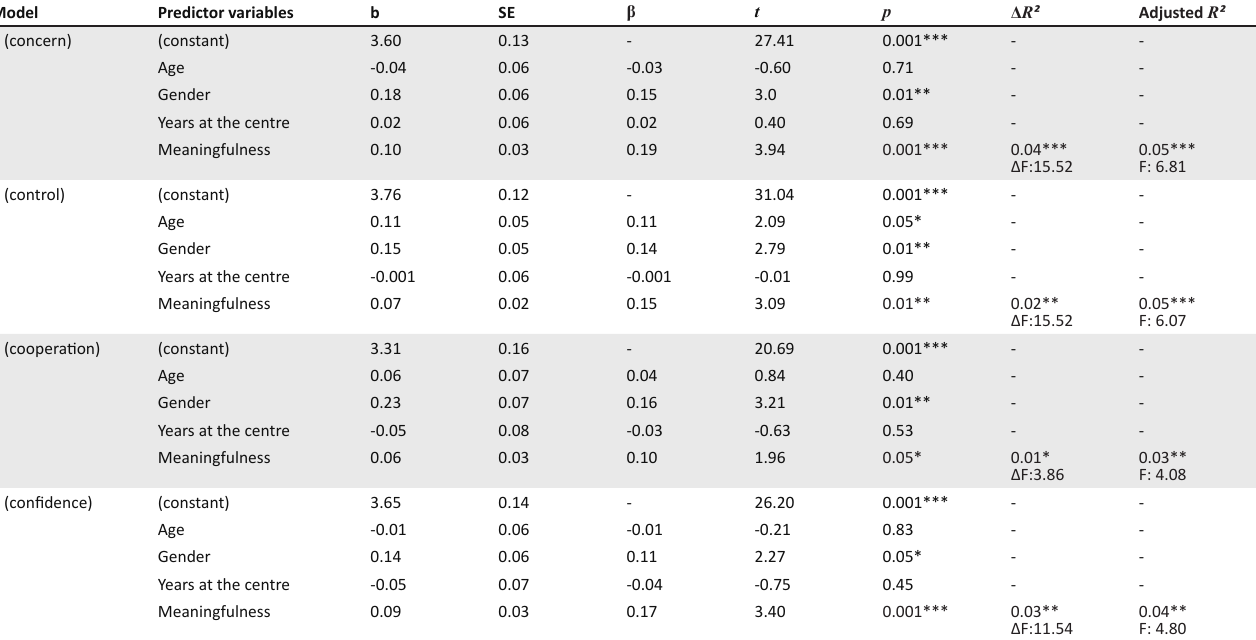
TABLE 2: Results of stepwise multiple-regression of age, gender, years at call centre and meaningfulness (OLQ) on concern, control, cooperation and confidence (CAAS) ( N = 409).